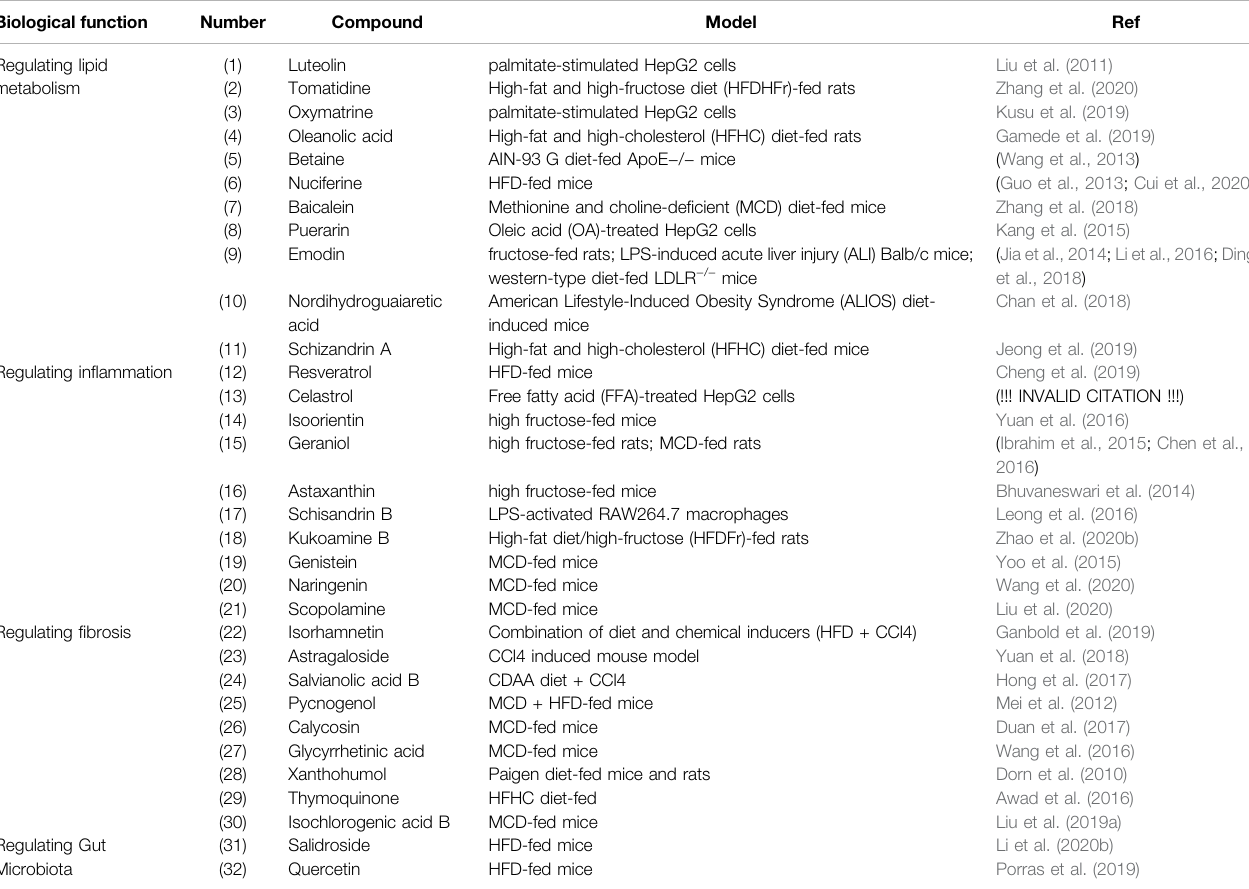
TABLE 1 | Potential natural compounds with anti-NASH-driven HCC effects. Biological